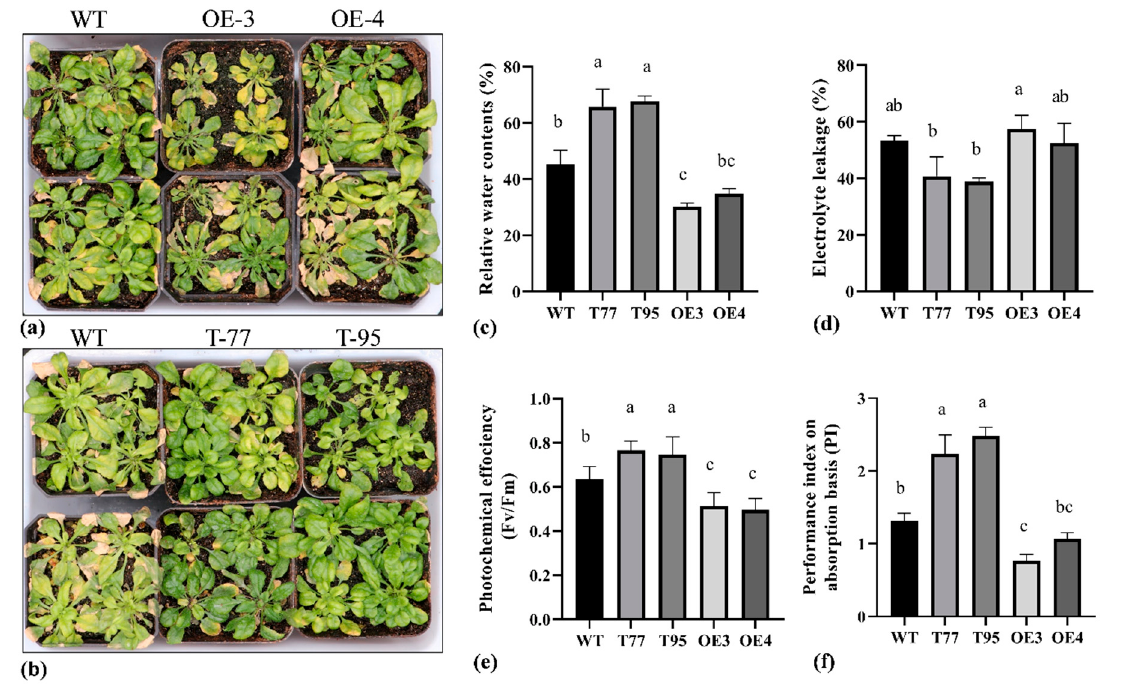
Figure 9. Comparison of salt stress tolerance of overexpressing TrHSFB2a lines (OE3 and OE4) and RNA interference T-DNA (T-77 and T-95) lines with wild type grown in nutrient soil for 28 days in normal conditions, irrigated with saline water gradients of 100 mM, 200 mM and 300 mM NaCl, each gradient for two times for two days. ( a , b ) Show phenotypic differences of wild + overexpression and wild + TDNA lines, respectively; ( c – f ) indicate relative water contents (%), electrolyte leakage (%), maximum quantum yield of PSII photochemistry (Fv/Fm) and performance index on absorption basis (PI ABS ), respectively, under salt stress condition. Bars represent mean ± SD values, and different small letters (a, b and c) represent significant statistical difference among means (one-way ANOVA, followed by Tuky test) between different lines.